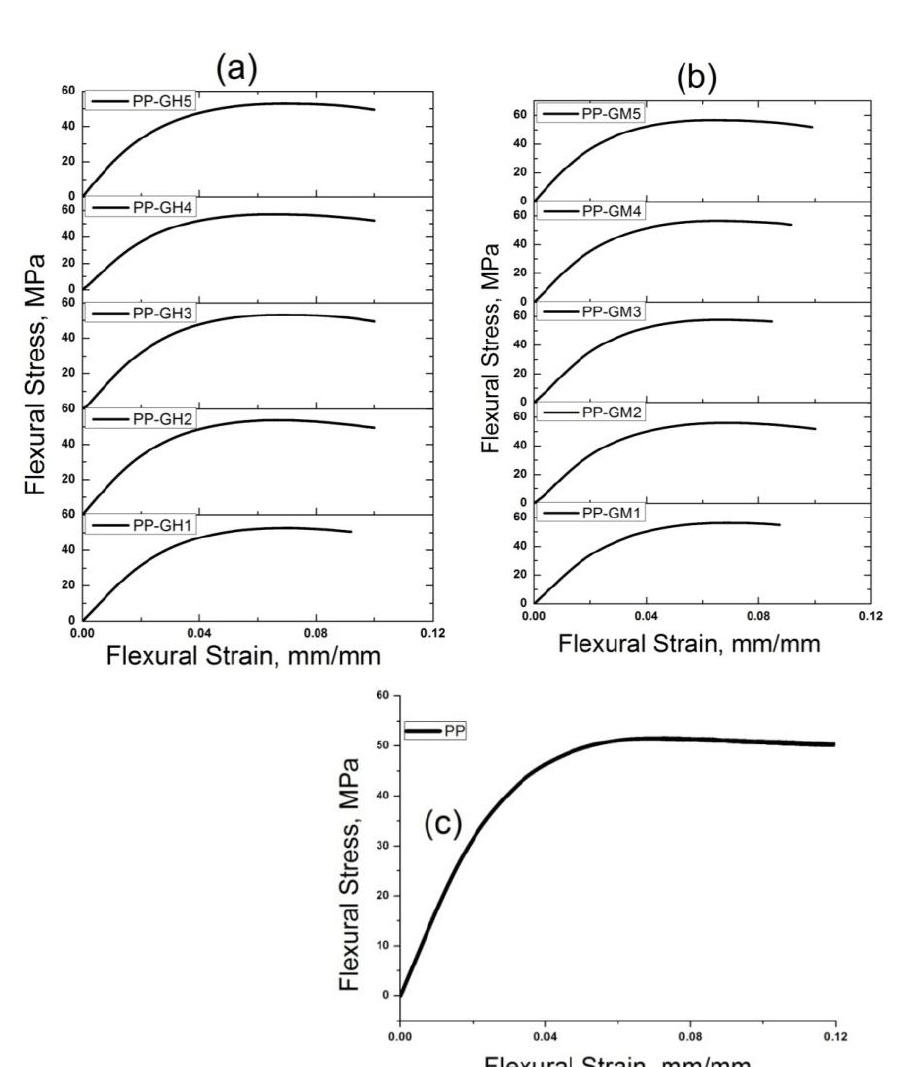
Figure 5. Flexural stress–strain curves of ( a ) PP-GH, ( b ) PP-GM nanocomposites, and ( c ) Virgin PP. Table 4. Data sheet presenting the consequences of flexural and impact behaviour.